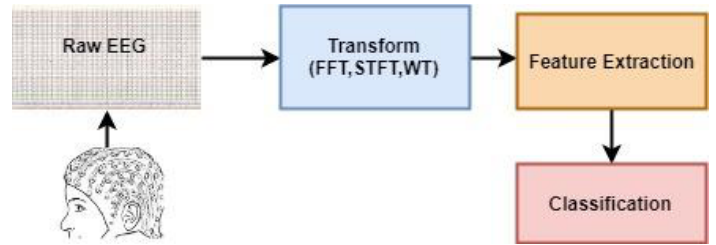
Figure 1. Common steps in conventional methods for the detection of epilepsy. EEG: electroencephalogram, FFT: fast fourier transform, STFT: short time fourier transform, WT: wavelet transform.